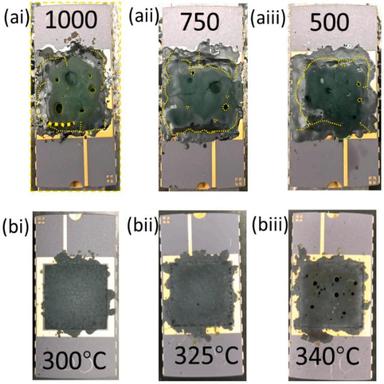
Photographs of encapsulated DIP (a) using different degrees of pre-polymerization PN encapsulant, namely (ai) 1000 rpm PN, (aii) 750 rpm PN, (aiii) 500 rpm PN cured at 400 ◦C; and (b) 1000 rpm PN encapsulant cured at different temperatures, namely (bi) 300 ◦C, (bii) 325 ◦C, (biii) 340 ◦C.